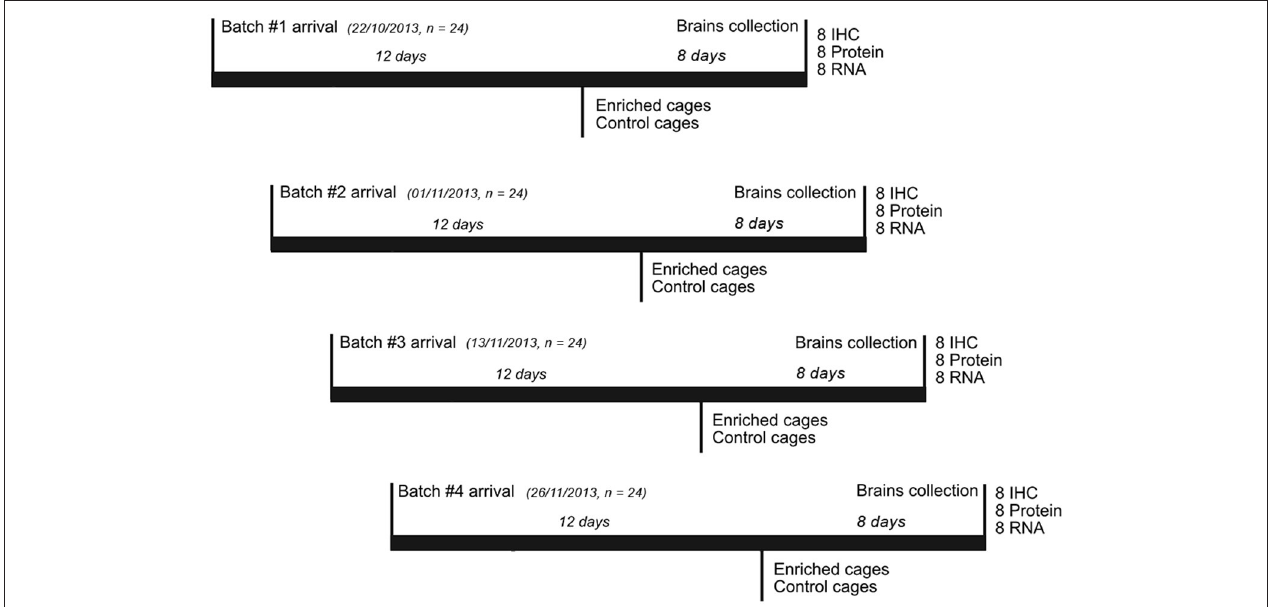
FIGURE 1 | Experimental timeline. The experiment was run in 4 replicates of 24 animals each. Each batch of animals was allowed to settle into standard mouse housing in the Newcastle University mouse facility for 12 days. After this, half the cages were taken to a different room, and the animals transferred to the enriched environments (keeping the same social groups). The other half of the cages were kept in the standard mouse housing in the mouse facility. After a further 8 days, the animals were killed and brains were collected as described in the Section Materials and Methods.